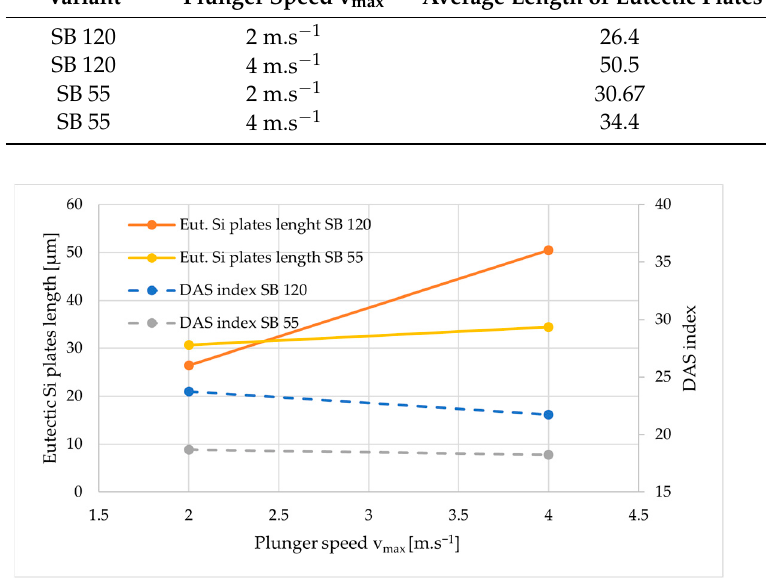
Figure 12. DAS index and average lengths of eutectic plates.